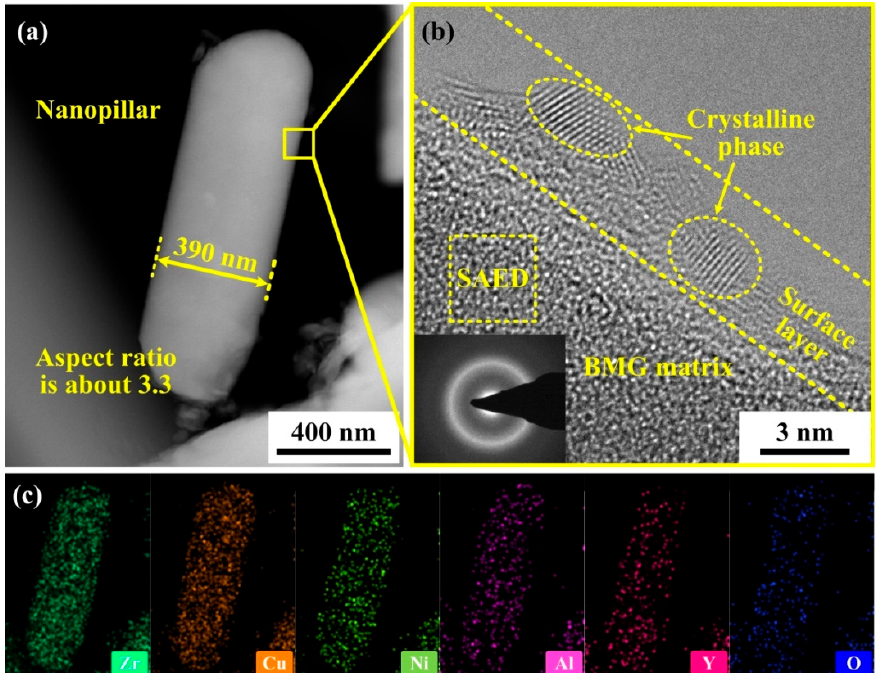
Figure 7. ( a ) Morphology of a single nanopillar with a diameter of 390 nm under TEM. ( b ) HRTEM image of nanopillar with two typical regions at the boundary; the insets are the selected area electron diffraction (SAED) patterns corresponding to the nanopillar matrix. ( c ) Energy spectrum analysis of a single nanopillar under TEM.